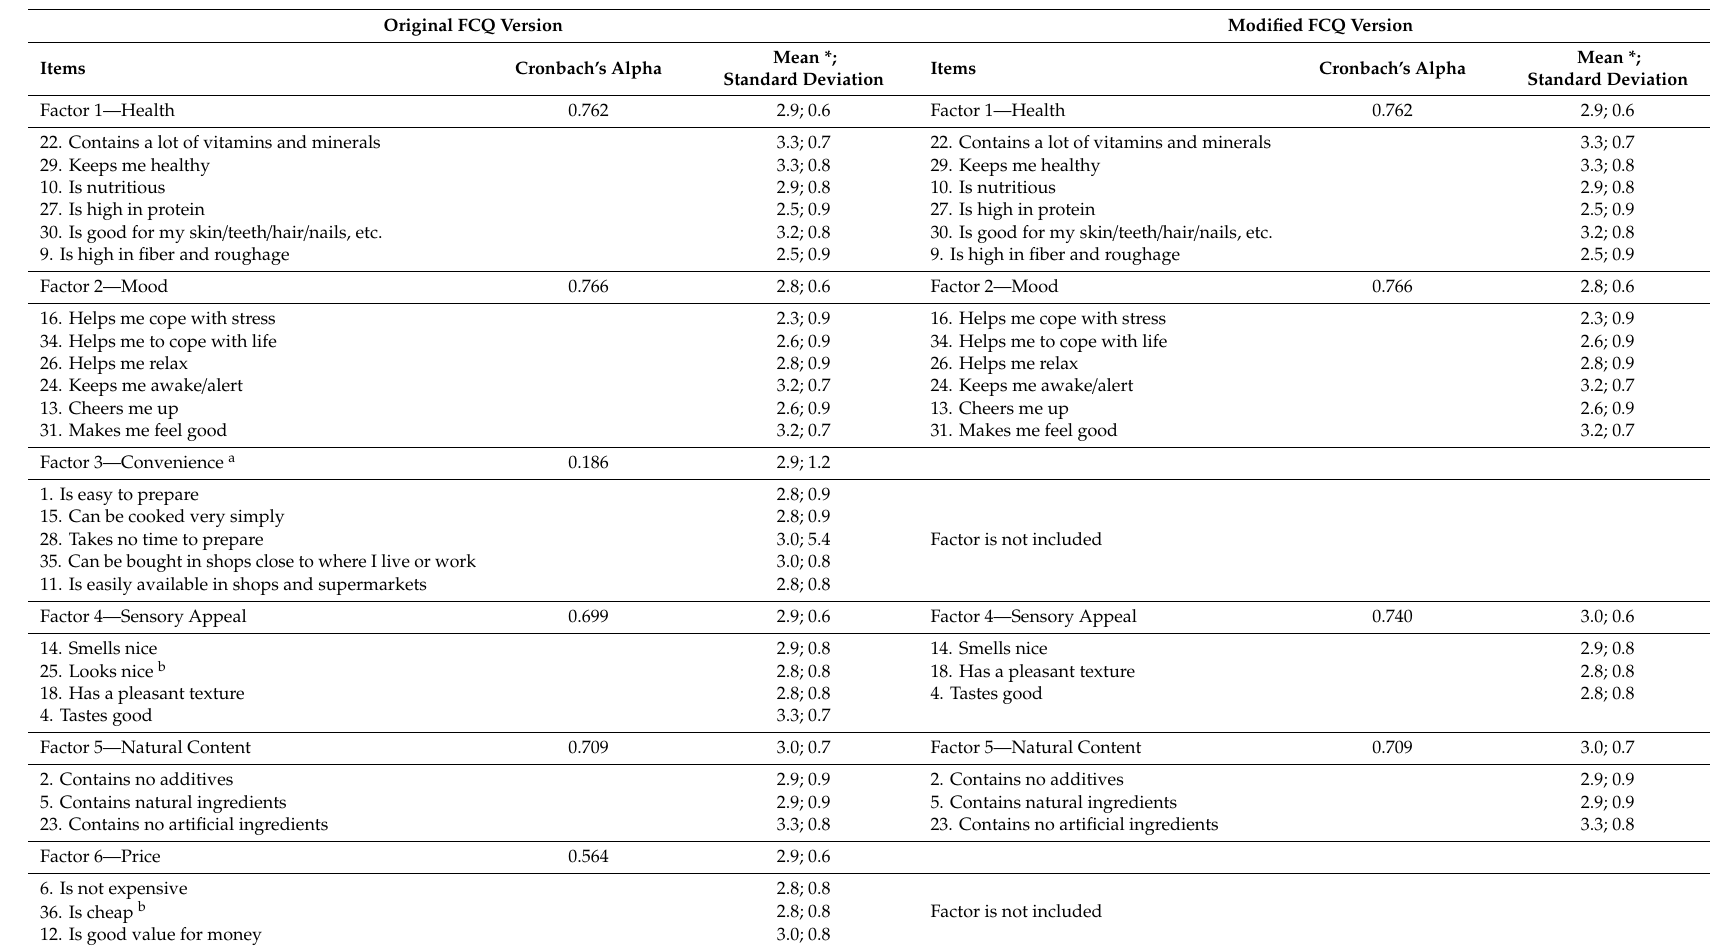
Table 1. Items in the original Food Choice Questionnaire (FCQ) version and short FCQ version and Cronbach’s alpha of each